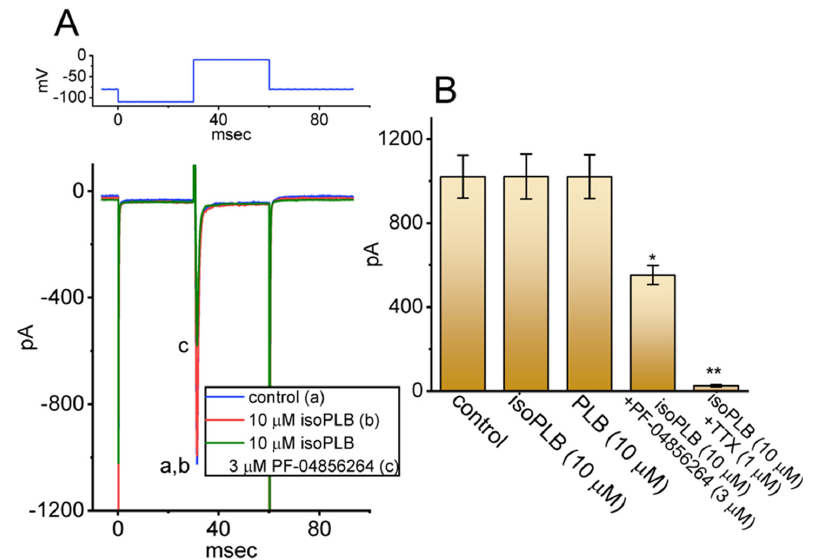
Figure 8. Effect on isoPLB on I Na in GH 3 cells. We bathed cells in a Ca 2+ -free Tyrode’s solution con- taining 0.5 mM CdCl 2 and 10 mM TEA, and the pipette was filled up with a Cs + -containing solution. ( A ) Original current traces obtained in the absence (a) and presence of 10 μ M isoPLB (b) or 10 μ M isoPLB plus 3 μ M PF-04856264. The top part depicts the voltage protocol applied to the tested cell. ( B ) Summary bar graph showing the effect of isoPLB, PLB, isoPLB plus PF-04856264, and isoPLB plus TTX on the peak amplitude of I Na during brief depolarizing pulse (30 msec in duration) from − 100 to − 10 mV (mean ± SEM; n = 7 for each bar). * Significantly different from control ( p < 0.05) and ** significantly different from control ( p < 0.01). The analysis among different groups was performed with ANOVA-1 ( p < 0.05).